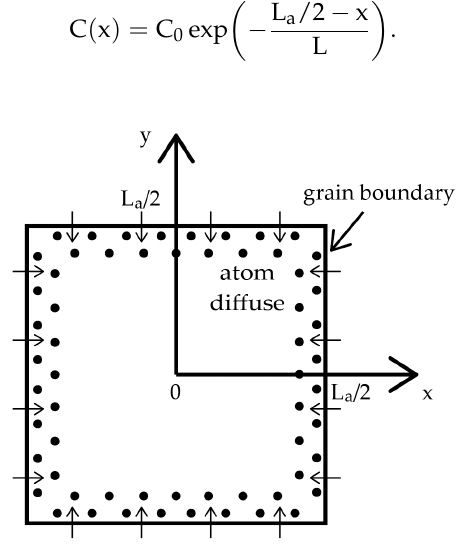
Figure 6. Square shape grain model of graphene.